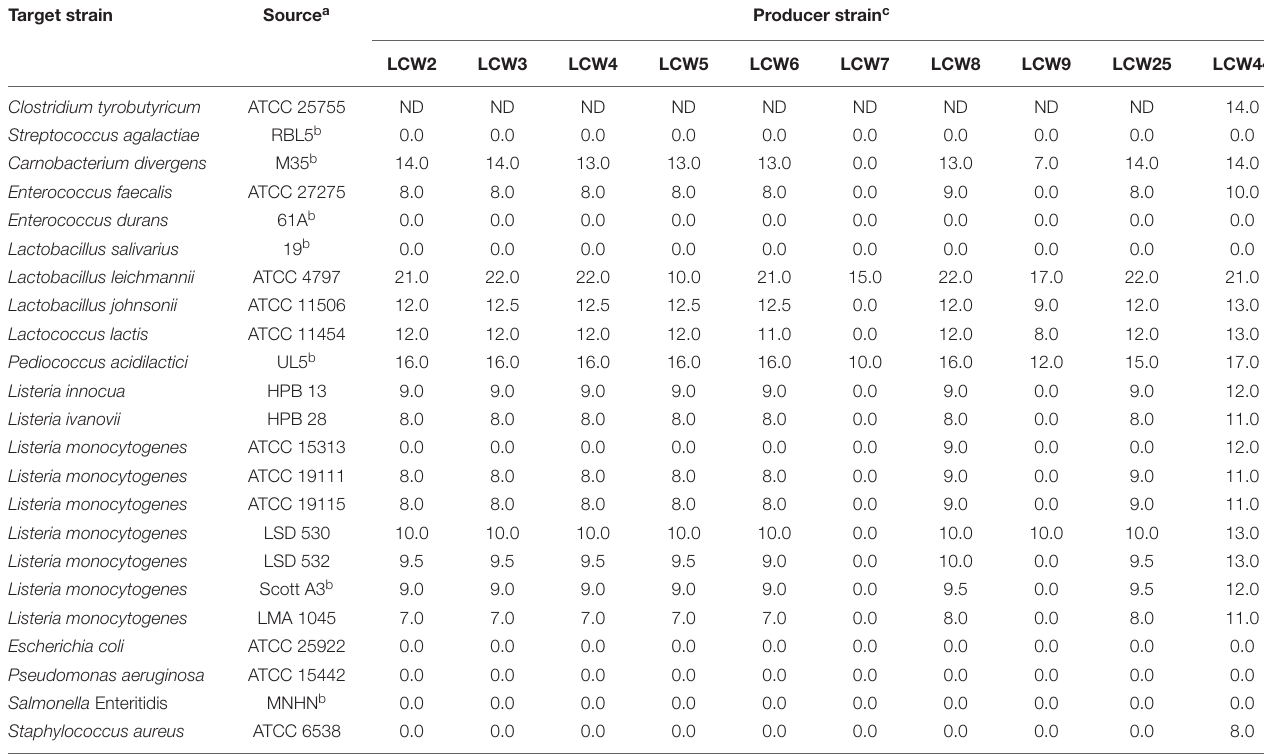
TABLE 1 | Antibacterial activity of cell-free culture of enterococci isolated from camel milk, as measured in the standard agar diffusion assay. Target